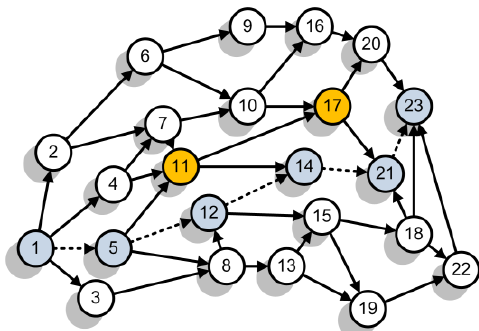
Figure 5. The sub-optimal route of GA-FSPP in Test-10